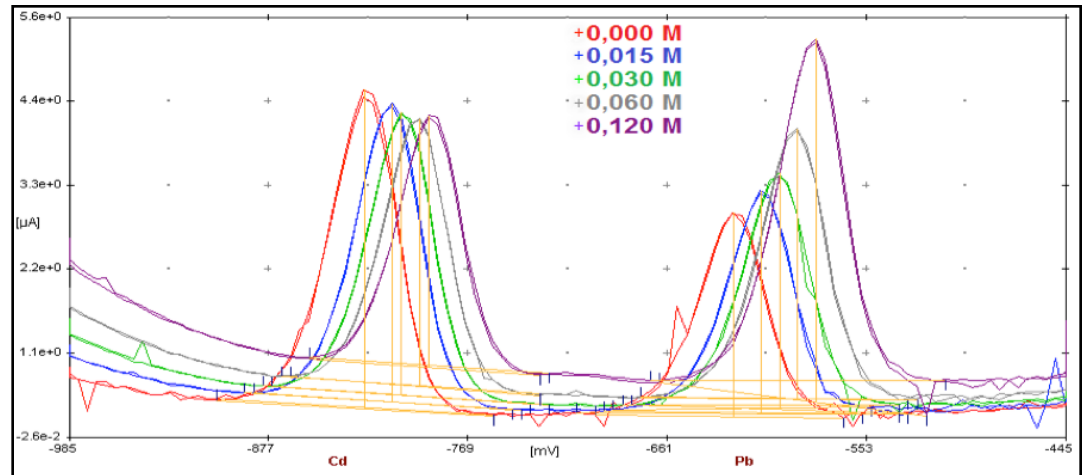
Figure 4. Stripping analysis of Pb and Cd at 15 μ g/L at pH = 2 and chloride ion activity of 10 − 2 M. Effect of the addition of chloride ions on stripping signals using the internal pseudo-reference Ag electrode.